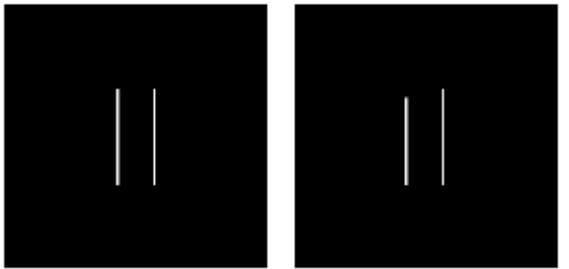
Figure 3. Examples of the different line task stimuli, with lines being the same length on the left and different lengths on the